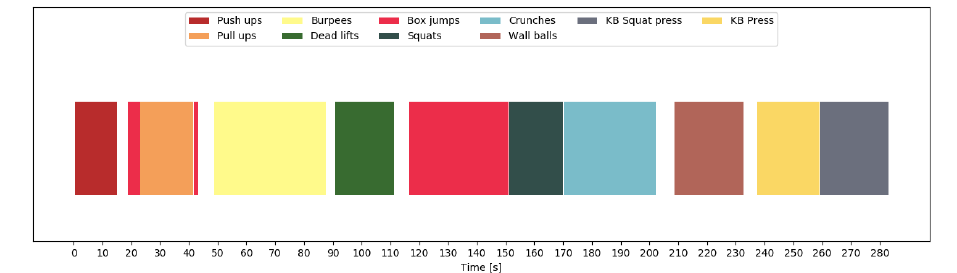
Figure 11. Chronological sequence of recognized exercises during free workout one for